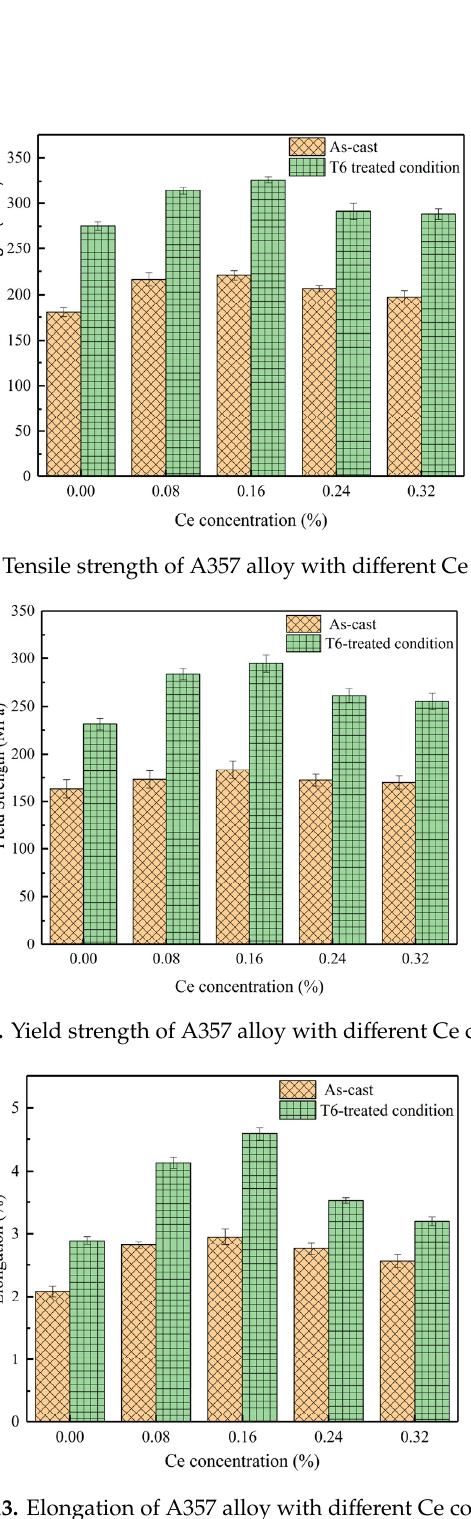
Figure 14. Q value of the experimental steel treated by different processes. In general, the mechanical properties of Al-Si casting alloys are mainly affected by the microstructure composition. The grain size was effectively refined when rare earth Ce was added to A357 casting alloy. The improvement of the mechanical properties of the casting is mainly attributed to the fact that the overall grain boundary area will significantly increase with the reduction of the alloy grain size, which can effectively prevent the dislocation movement. At the same time, the morphology of eutectic Si is changed into a fine spherical shape, which weakened the cleavage effect of eutectic Si on Al matrix, and further improved its mechanical properties. In addition, with the addition of rare earth Ce in the modified alloy, the morphology of some β -Fe phases appeared in a spherical shape, as shown in Figure 15. Moreover, when part of the Ce atoms enters the β -phase (Al 5 FeSi) clusters, some Fe atoms will be replaced by Ce, which causes the needle-like morphology of the Fe-containing intermetallic to be transformed into α -phase (AlSiFeCe)-containing rare earth Ce (Figure 16). The harmful effect of beta on the mechanical properties of the alloy is effectively reduced by the α -phase formed after adding rare earth Ce. However, the mechanical properties of the material decrease when excessive Ce is added. This may be due to the addition of excessive Ce leads to the increase of needle-like morphologies β -Fe size. Meanwhile, some needle-like, flake-like, and plate-like morphology (AlSiCe) intermetallic compounds were observed in the α -Al matrix, as shown in Figure 17.